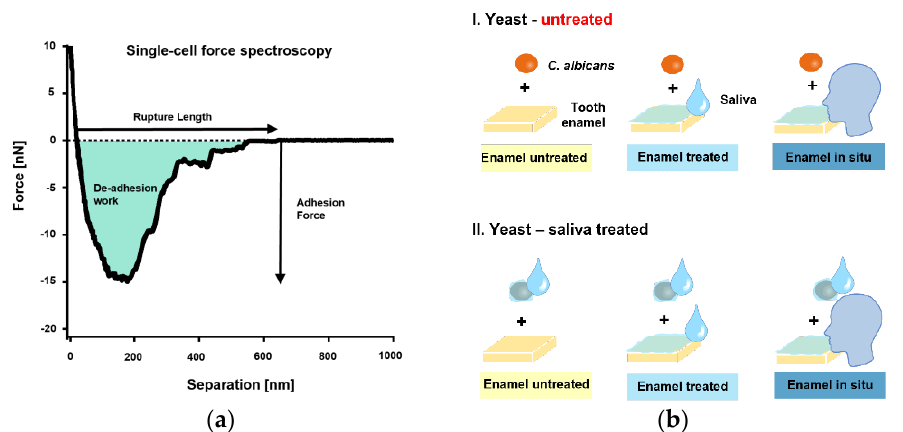
Figure 2. Single-cell force spectroscopy with C. albicans and experimental conditions. ( a ): FluidFM was used to bring a single cell into contact with a bovine tooth enamel sample for short surface contact times of 0 s or 5 s. The yeast probe was then retracted, and the adhesion force, rupture lengths and de-adhesion work were quantified ( b ): The experimental design.